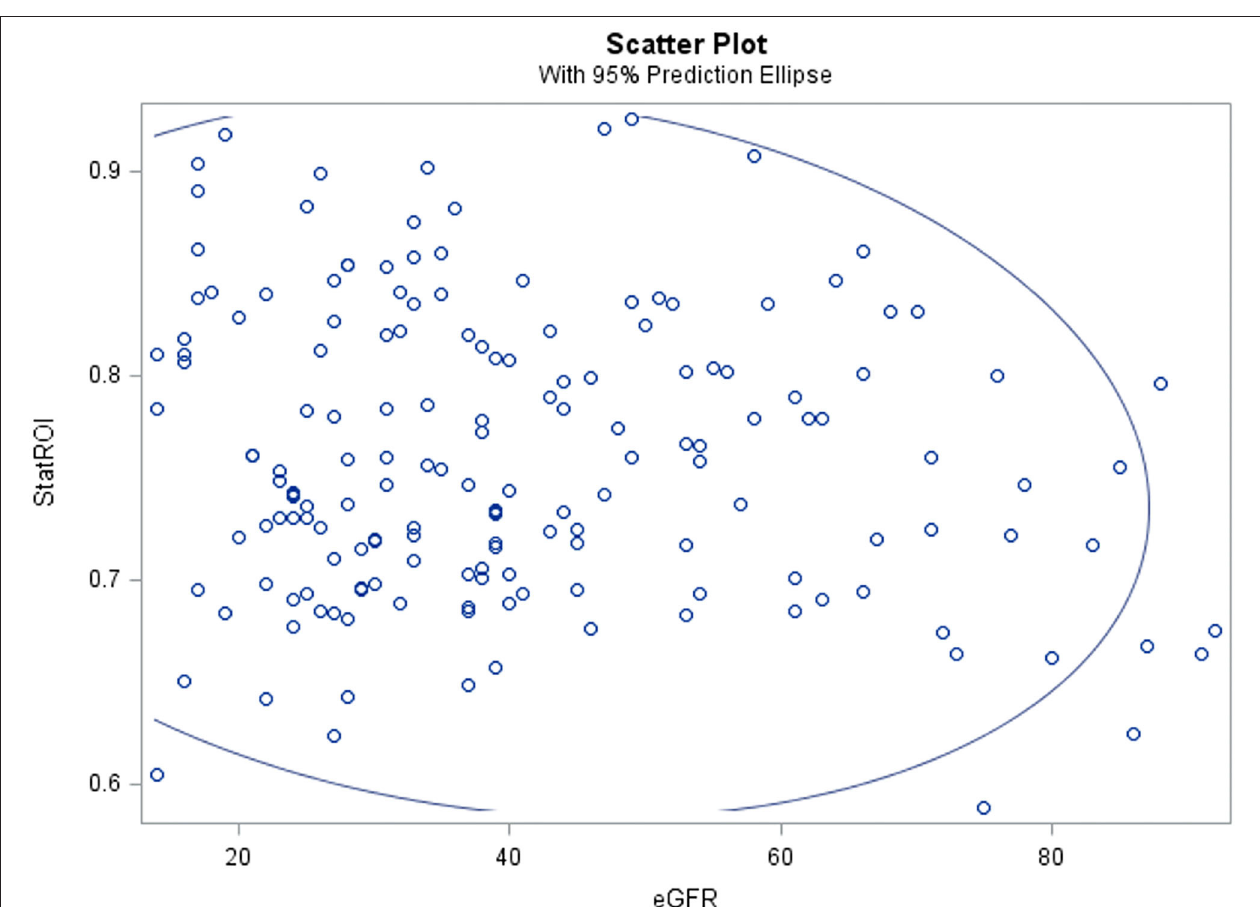
FIGURE 1 | Brain amyloid- β burden assessed non-invasively on positron emission tomography (statistically defined region of interest score, statROI) was not correlated with estimated glomerular filtration rate (eGFR) in a cohort of community-dwelling 90 + year-olds.